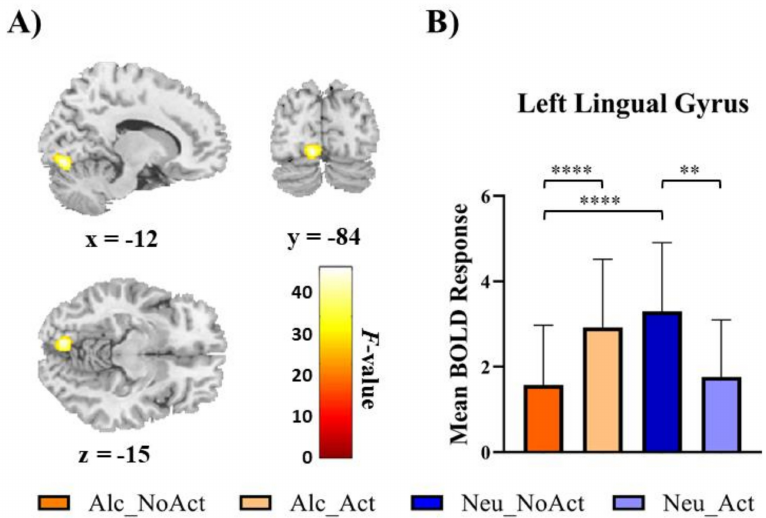
Figure 3. Neural interaction among cue category and cue type. ( A ) the group’s significant BOLD activity means the interaction between beverage type and action context; ( B ) mean BOLD re- sponse in the left lingual gyrus for each condition. Error bars show the associated beta values of the conditions in the significant cluster of the lingual gyrus. ** p < 0.01, **** p < 0.0001 after Bonferroni multiple-comparisons correction. Alc_NoAct = alcohol cues without drinking actions, Alc_Act = alcohol cues with drinking actions, Neu_NoAct = non-alcohol cues without drinking actions, Neu_Act = non-alcohol cues with drinking actions.